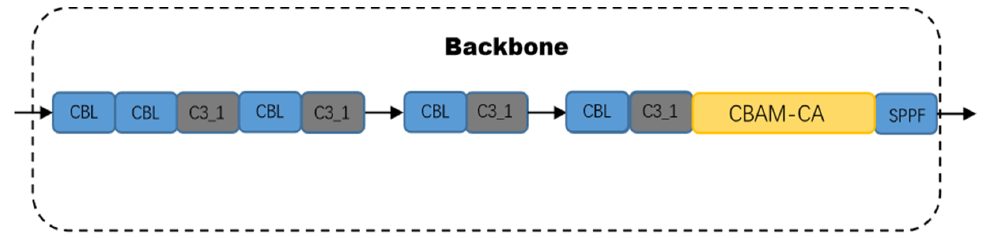
Figure 6. The Backbone structure incorporated with the CBAM-CA mechanism .